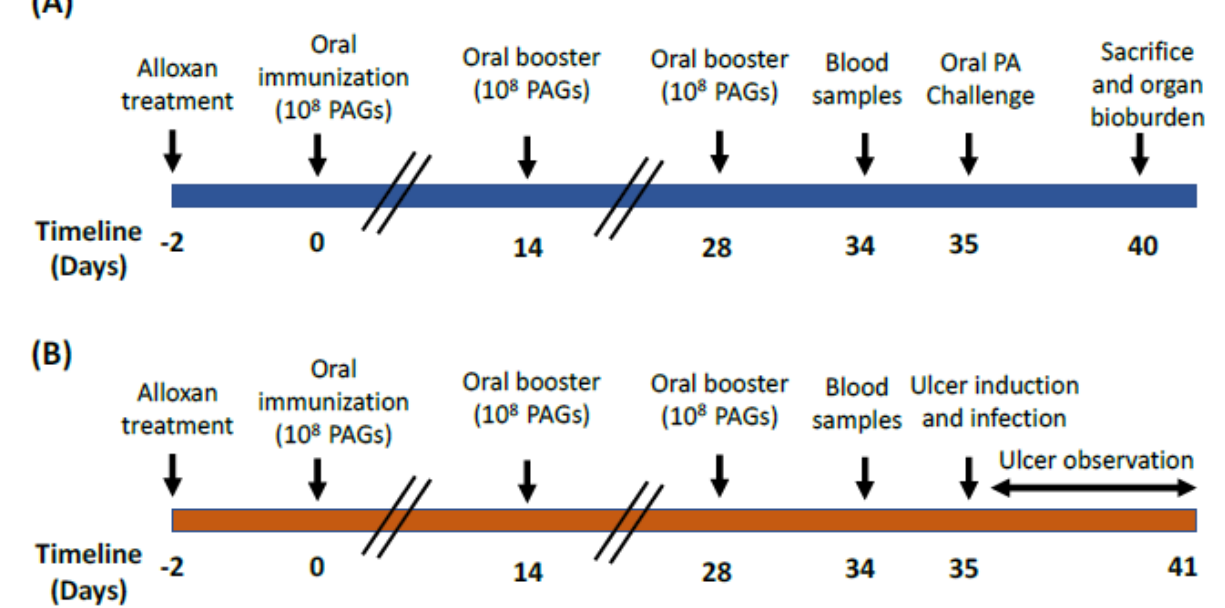
Figure 1. An illustration of the experimental design on animals . Experimental protocols are shown for rats challenged orally ( A ) or through ulcer induction and infection ( B ). Negative control groups (not shown) were also included and were given saline instead of the vaccine. Each experimental group included six rats. Blood samples were collected on day 34 to determine the agglutinating antibody titers, phagocytic and killing activities, and serum IFN- γ levels. T he timeline is not to